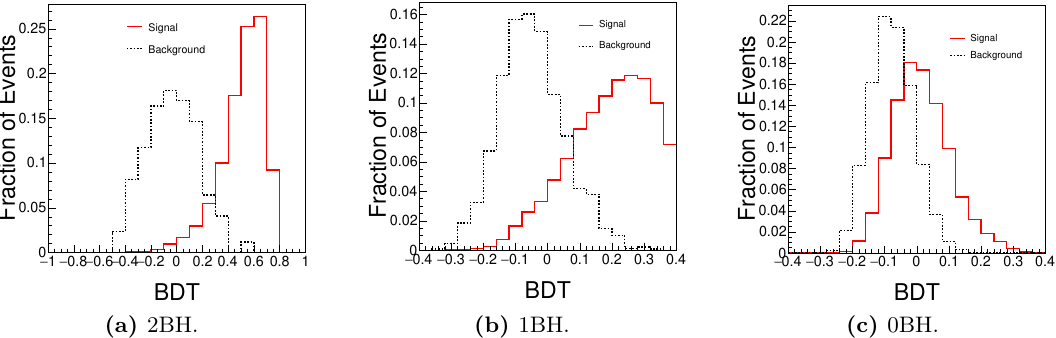
Figure 5 . The response of the discriminants to the g V,b 2 signal and background at 14 TeV LHC with (a) 2BH, (b) 1BH, and (c) 0BH.